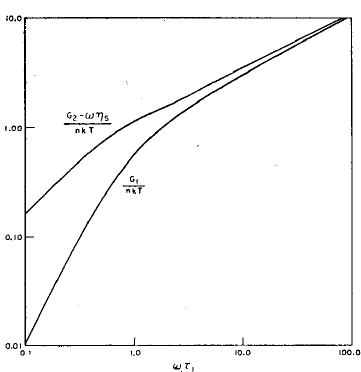
Figure 7. The Rouse model has been explicitly developed in the frame of non-interacting polymer chains in dilute solutions. Reproduced from [31], with the permission of AIP